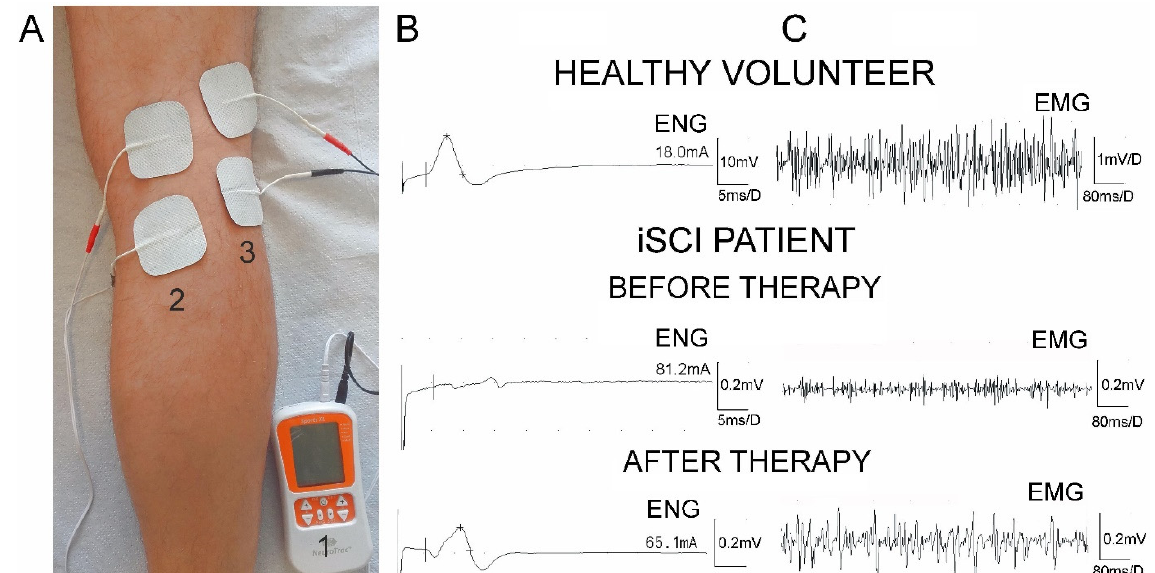
Figure 3. ( A ) Photograph of the device (1) for tibial (2), and peroneal (3) nerve electrostimulation with the presentation of the position of stimulating electrodes along the anatomical passage of popliteal fossa, and laterally to the head of the fibula, respectively. ( B ) Examples of M-wave-evoked potential recordings following electrical stimulation of peroneal nerves during electroneurographic studies. ( C ) Examples of electromyographical recordings from tibialis anterior muscles. The comparisons of neurophysiological recordings from a healthy volunteer and one of the patients with iSCI before and after therapy are presented.